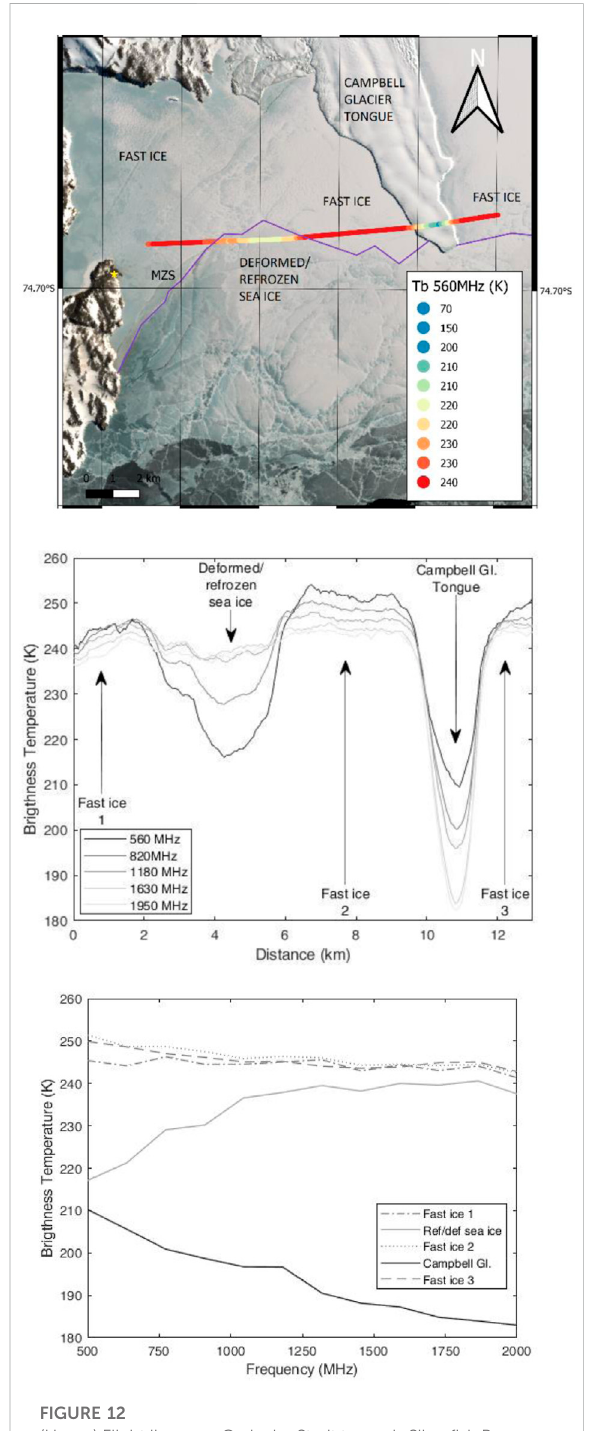
FIGURE 12 (Upper) Flight line over Gerlache Strait towards Silver fi sh